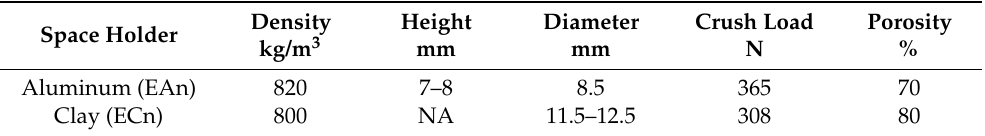
Table 1. Physical properties of aluminum and porous clay